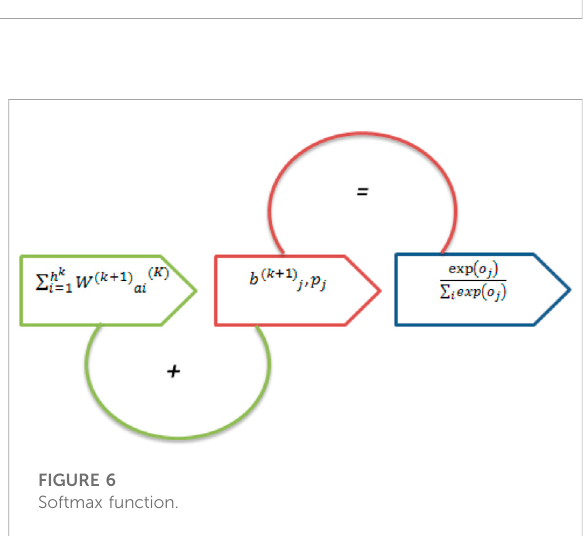
FIGURE 4 Wearable sensor framework.